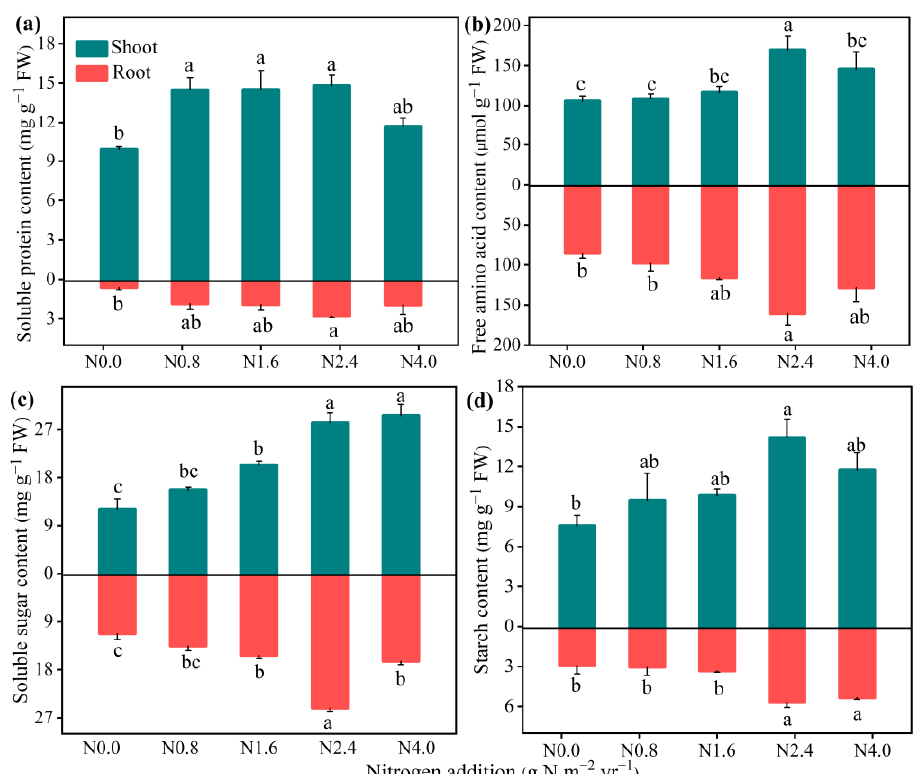
Figure 4. Effects of N addition on N assimilation products of A. mongolicum . Values are the mean ± standard error ( n = 4). ( a ) soluble protein content (SPC), ( b ) free amino acid content (FAA), ( c ) soluble sugar content (SSC), and ( d ) starch content (SC). Different letters above the bars indicate significance differences among the N addition treatments ( p < 0.05).